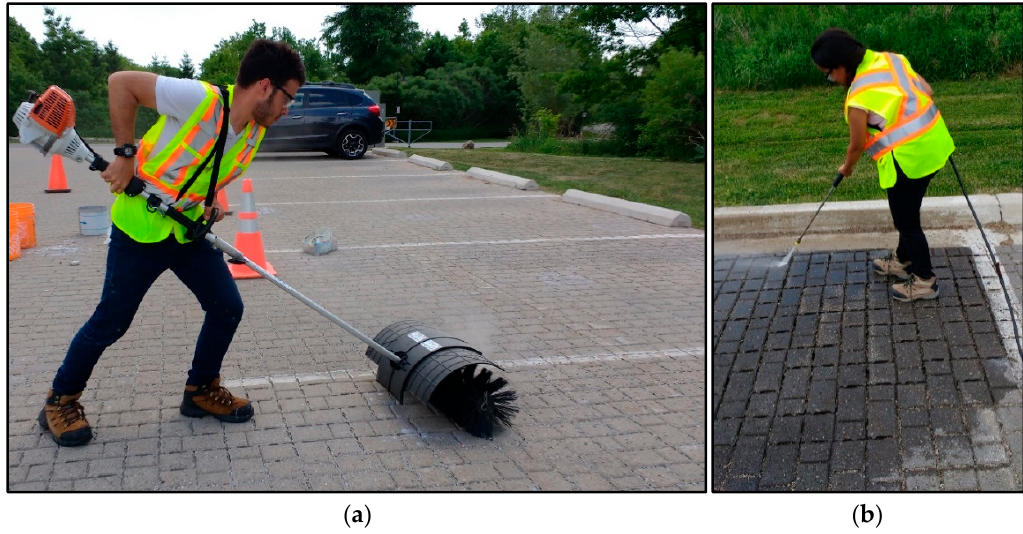
Figure 2. Surface Treatment Technologies ( a ) Power Brush ( b ) Pressure Wash at CVC,